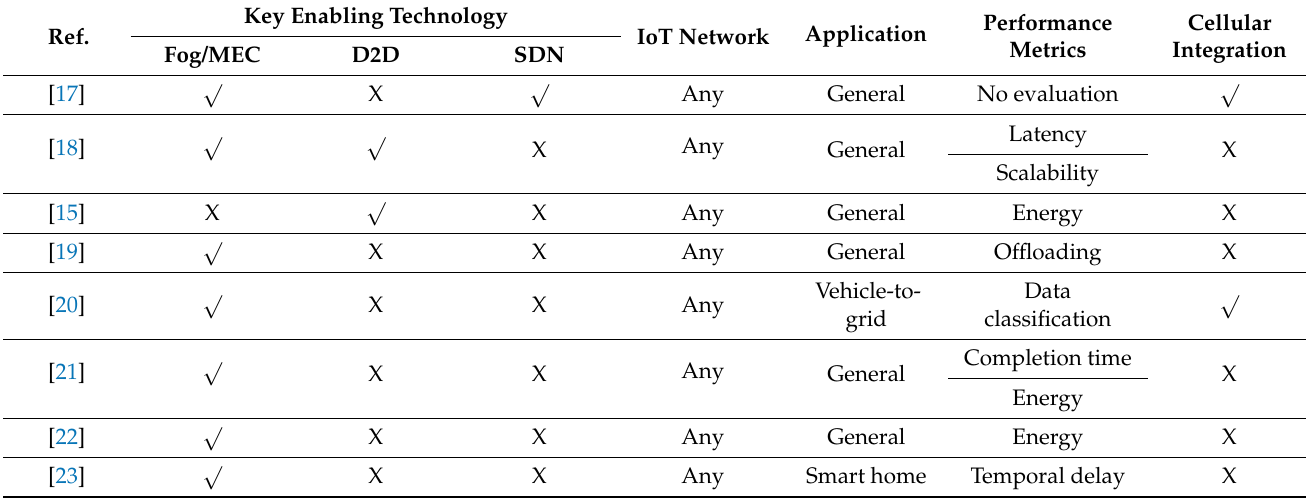
Table 1. Internet of things (IoT)/5G system compared to existing related works.